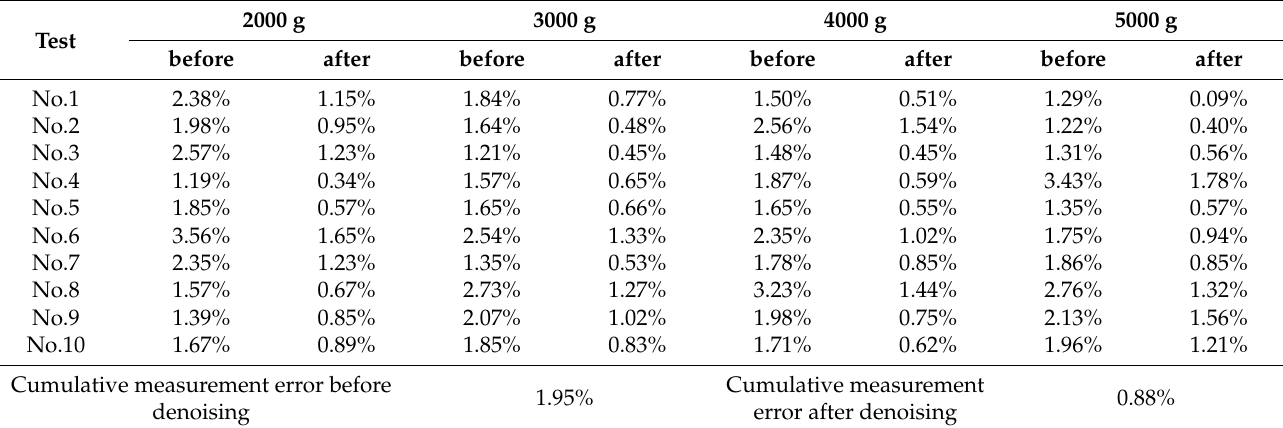
Table 2. Comparison of cumulative measurement error results after denoising and before